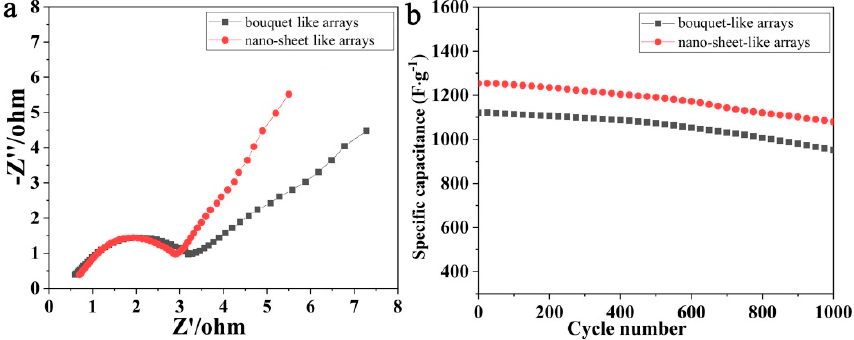
Figure 7. ( a ) Nyquist plots of MHP/ACF electrodes; ( b ) Cycling properties of MHP/ACF electrodes (current density: 10 mA . cm − 2 ).